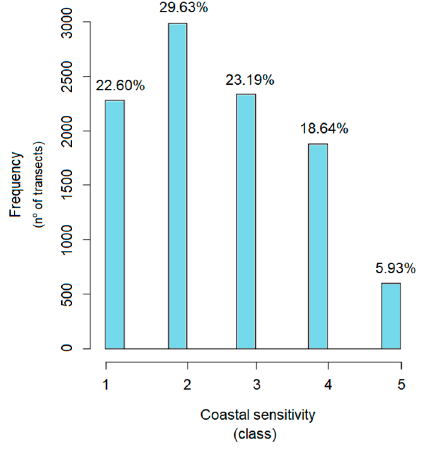
Figure 6. Frequency of coastal sensitivity classes.